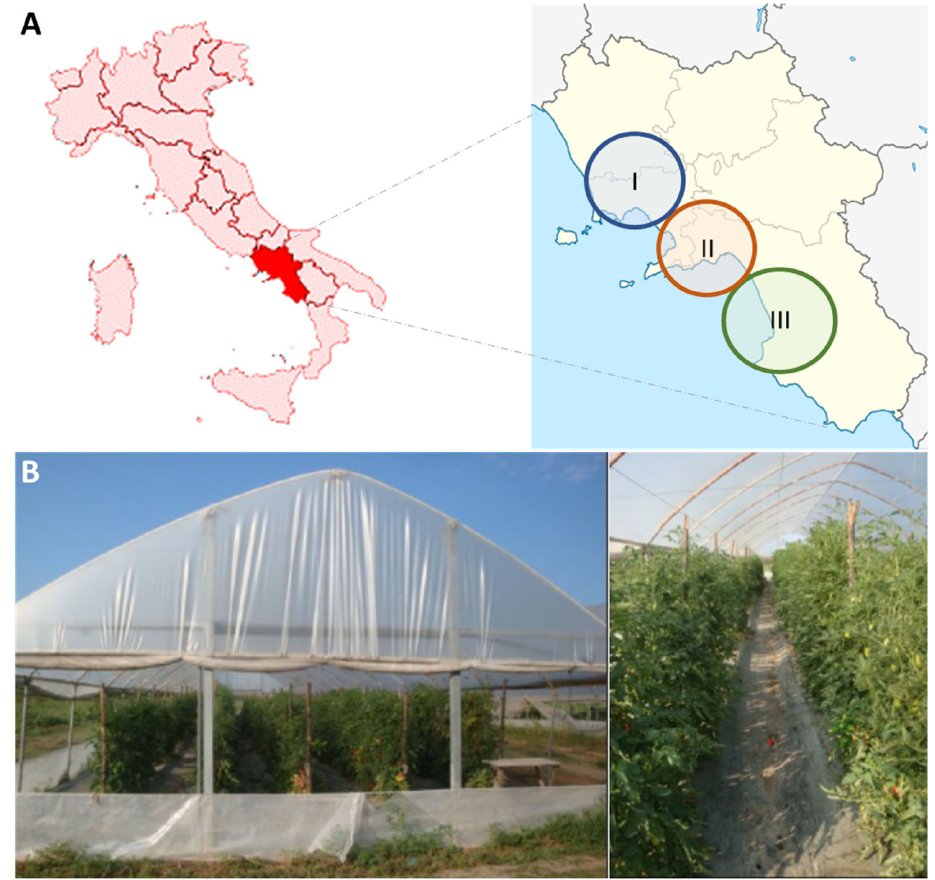
Figure 1. Details of collecting and cultivation site for the ‘San Marzano’ and ‘Re Fiascone’ landraces. ( A ) The Campania region with three major districts: Napoli (I), Agro Sarnese-Nocerino (II) and Piana Del Sele (III). ( B ) Details of cultivation at the experimental farm of the Research Centre for Vegetable and Ornamental Crops located in Pontecagnano (SA).